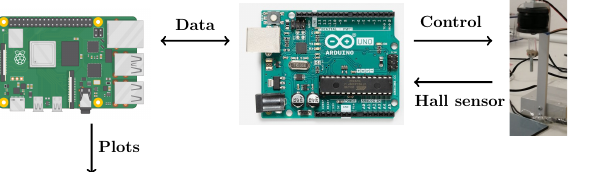
Figure 2. Communication scheme. The leftmost board represents a Raspberry-Pi used to collect and store measurements from the control system. The control system is implemented in the Arduino Uno board (middle), which communicates in real time with the MagLev